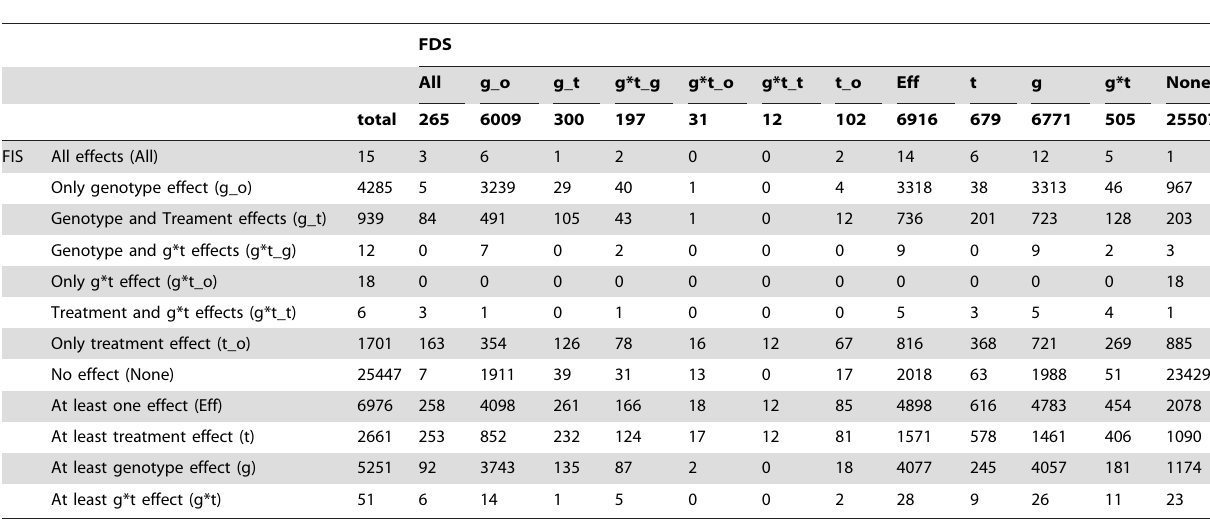
Table 1. Genes showing ANOVA effects for two drought